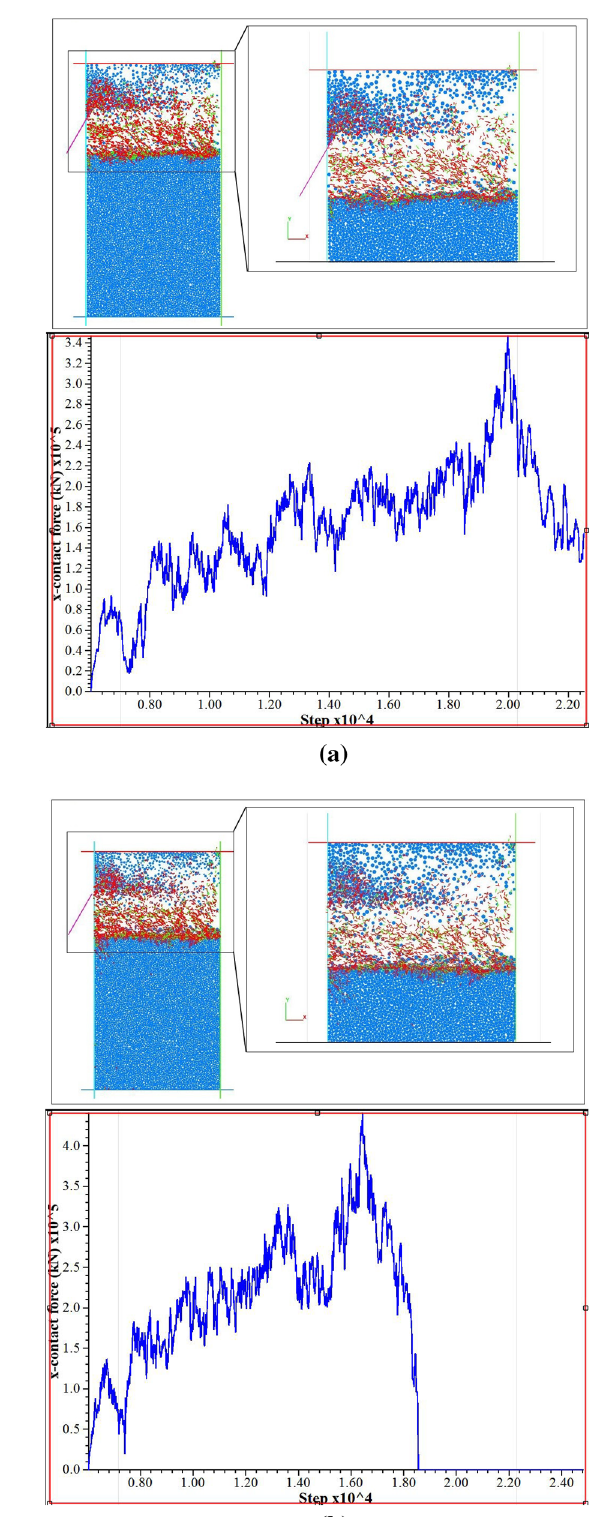
Fig. 16 Results of plow model with zero-degree angle: a Model 19, b Model